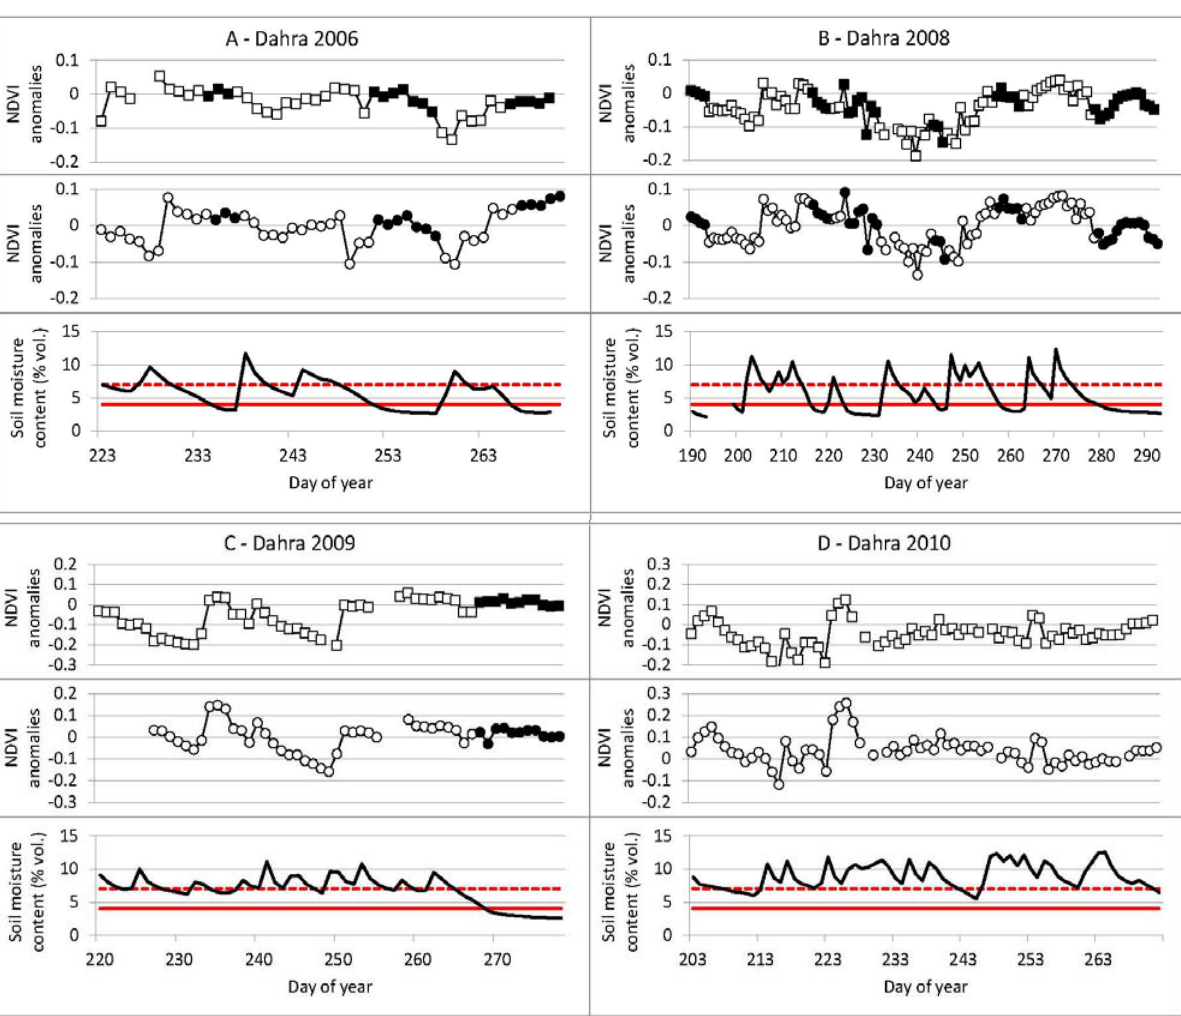
Figure 6. Normalized Difference Vegetation Index (NDVI) anomalies and soil moisture: Top pane: NDVI anomalies from Savitsky-Golay detrending. Middle pane: NDVI anomalies from 2nd order detrending (solid dots: NDVI anomalies during Soil Moisture Content (SMC) < Wilting point (WP) + 1. Hollow dots: SMC > WP + 1). Bottom pane: Dark grey line: SMC. Red line: WP + 1 (vol.%). Red dashed line: Field capacity (except at Demokeya, here it represents 8